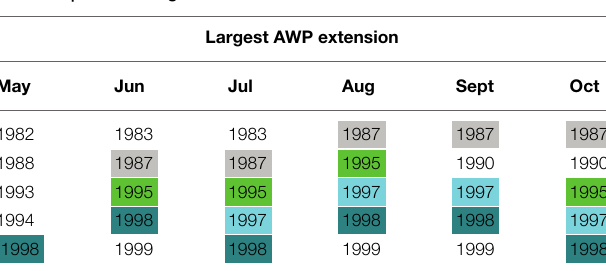
TABLE 3 | Years of highest AWP area for